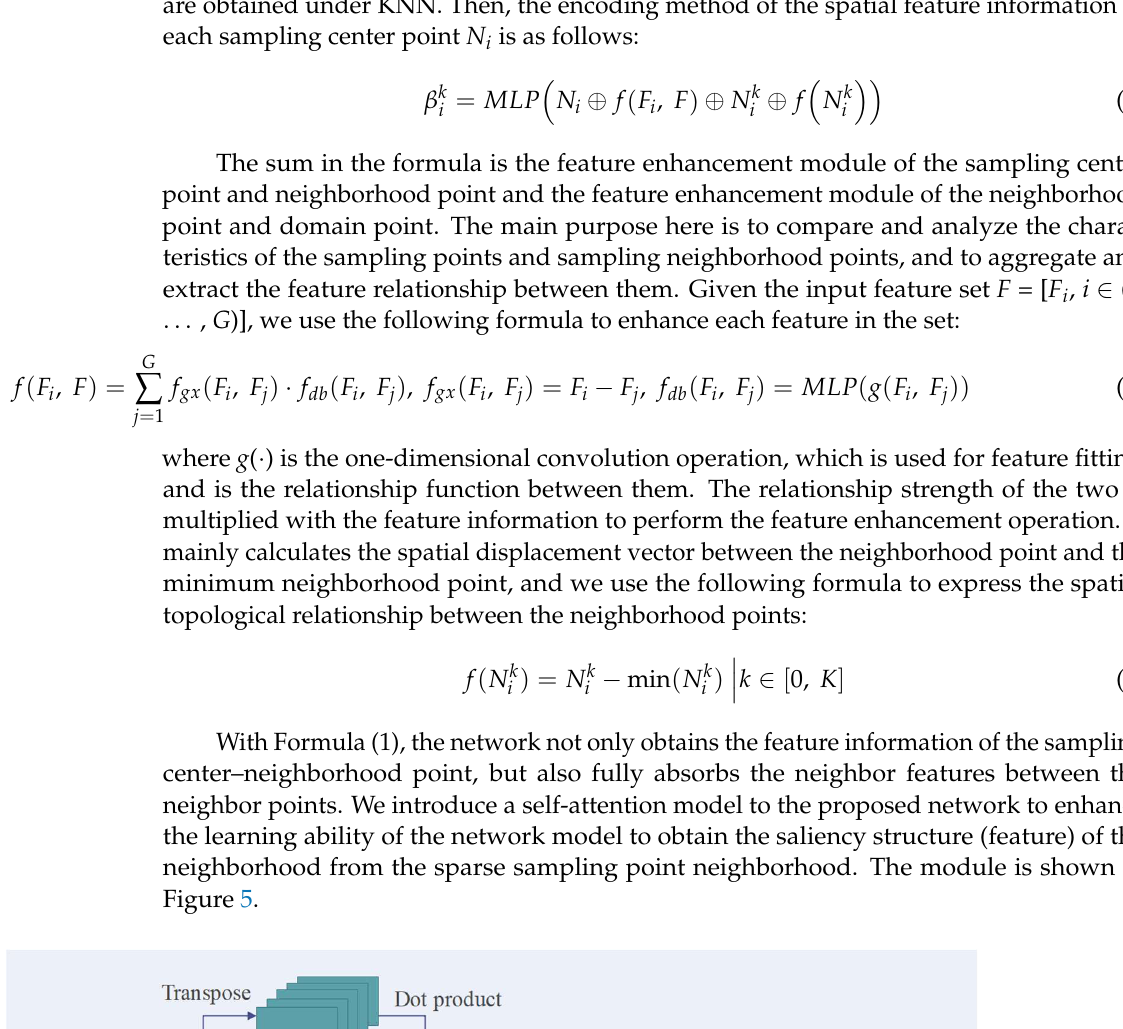
Figure 4. SC feature learning module for the downsampling layer.